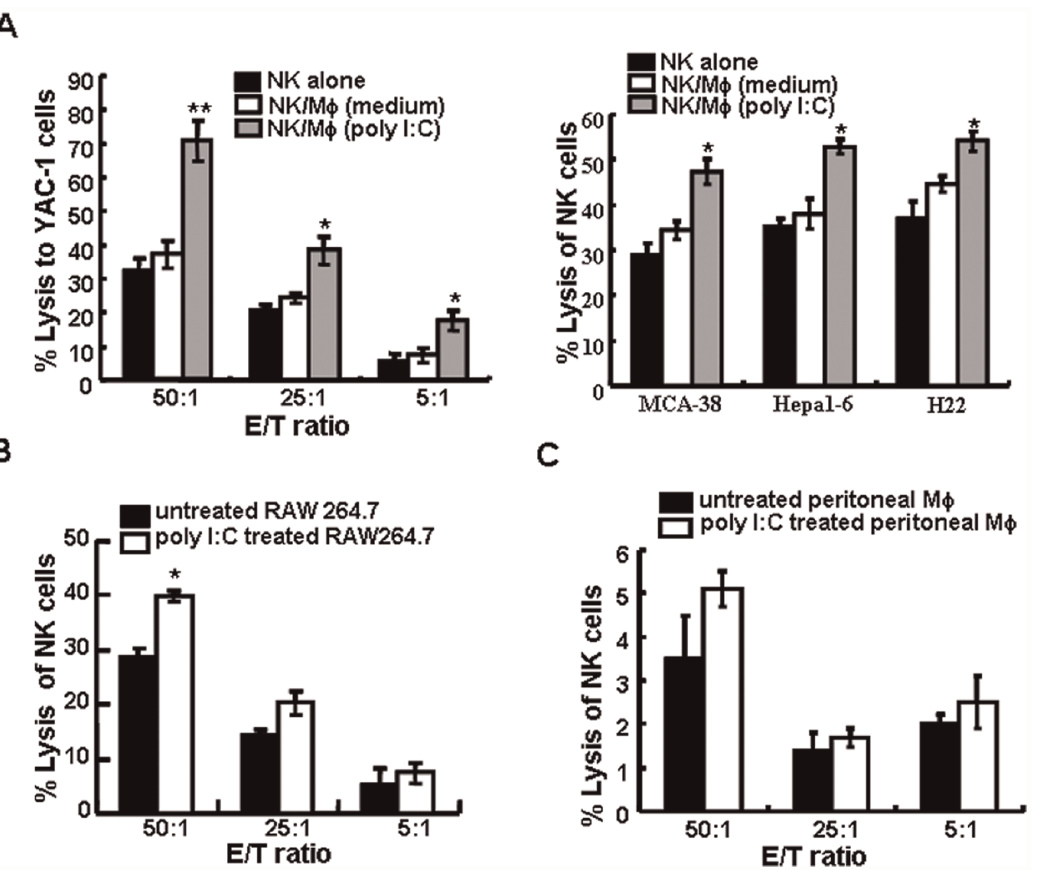
Figure 1. Murine macrophages increase NK cell cytotoxicity to susceptible target cells. Freshly purified splenic NK cells were first co- cultured with untreated or poly I:C-pretreated macrophages for 24 h at an NK/macrophage ratio of 5:1, and then separated by vibrating gently to be used as effector cells against susceptible target cells. NK cell-mediated lysis against YAC-1 cells, Hepa1-6 cells, MCA38 cells, H22 cells (A), RAW264.7 cells (B) or peritoneal M w (C) was assessed by the 51 Cr release assay at various E:T rations. Data are expressed as the mean 6 SD from at least three separate experiments. *p , 0.05, **p , 0.01 versus untreated cells using the paired Student’s test.